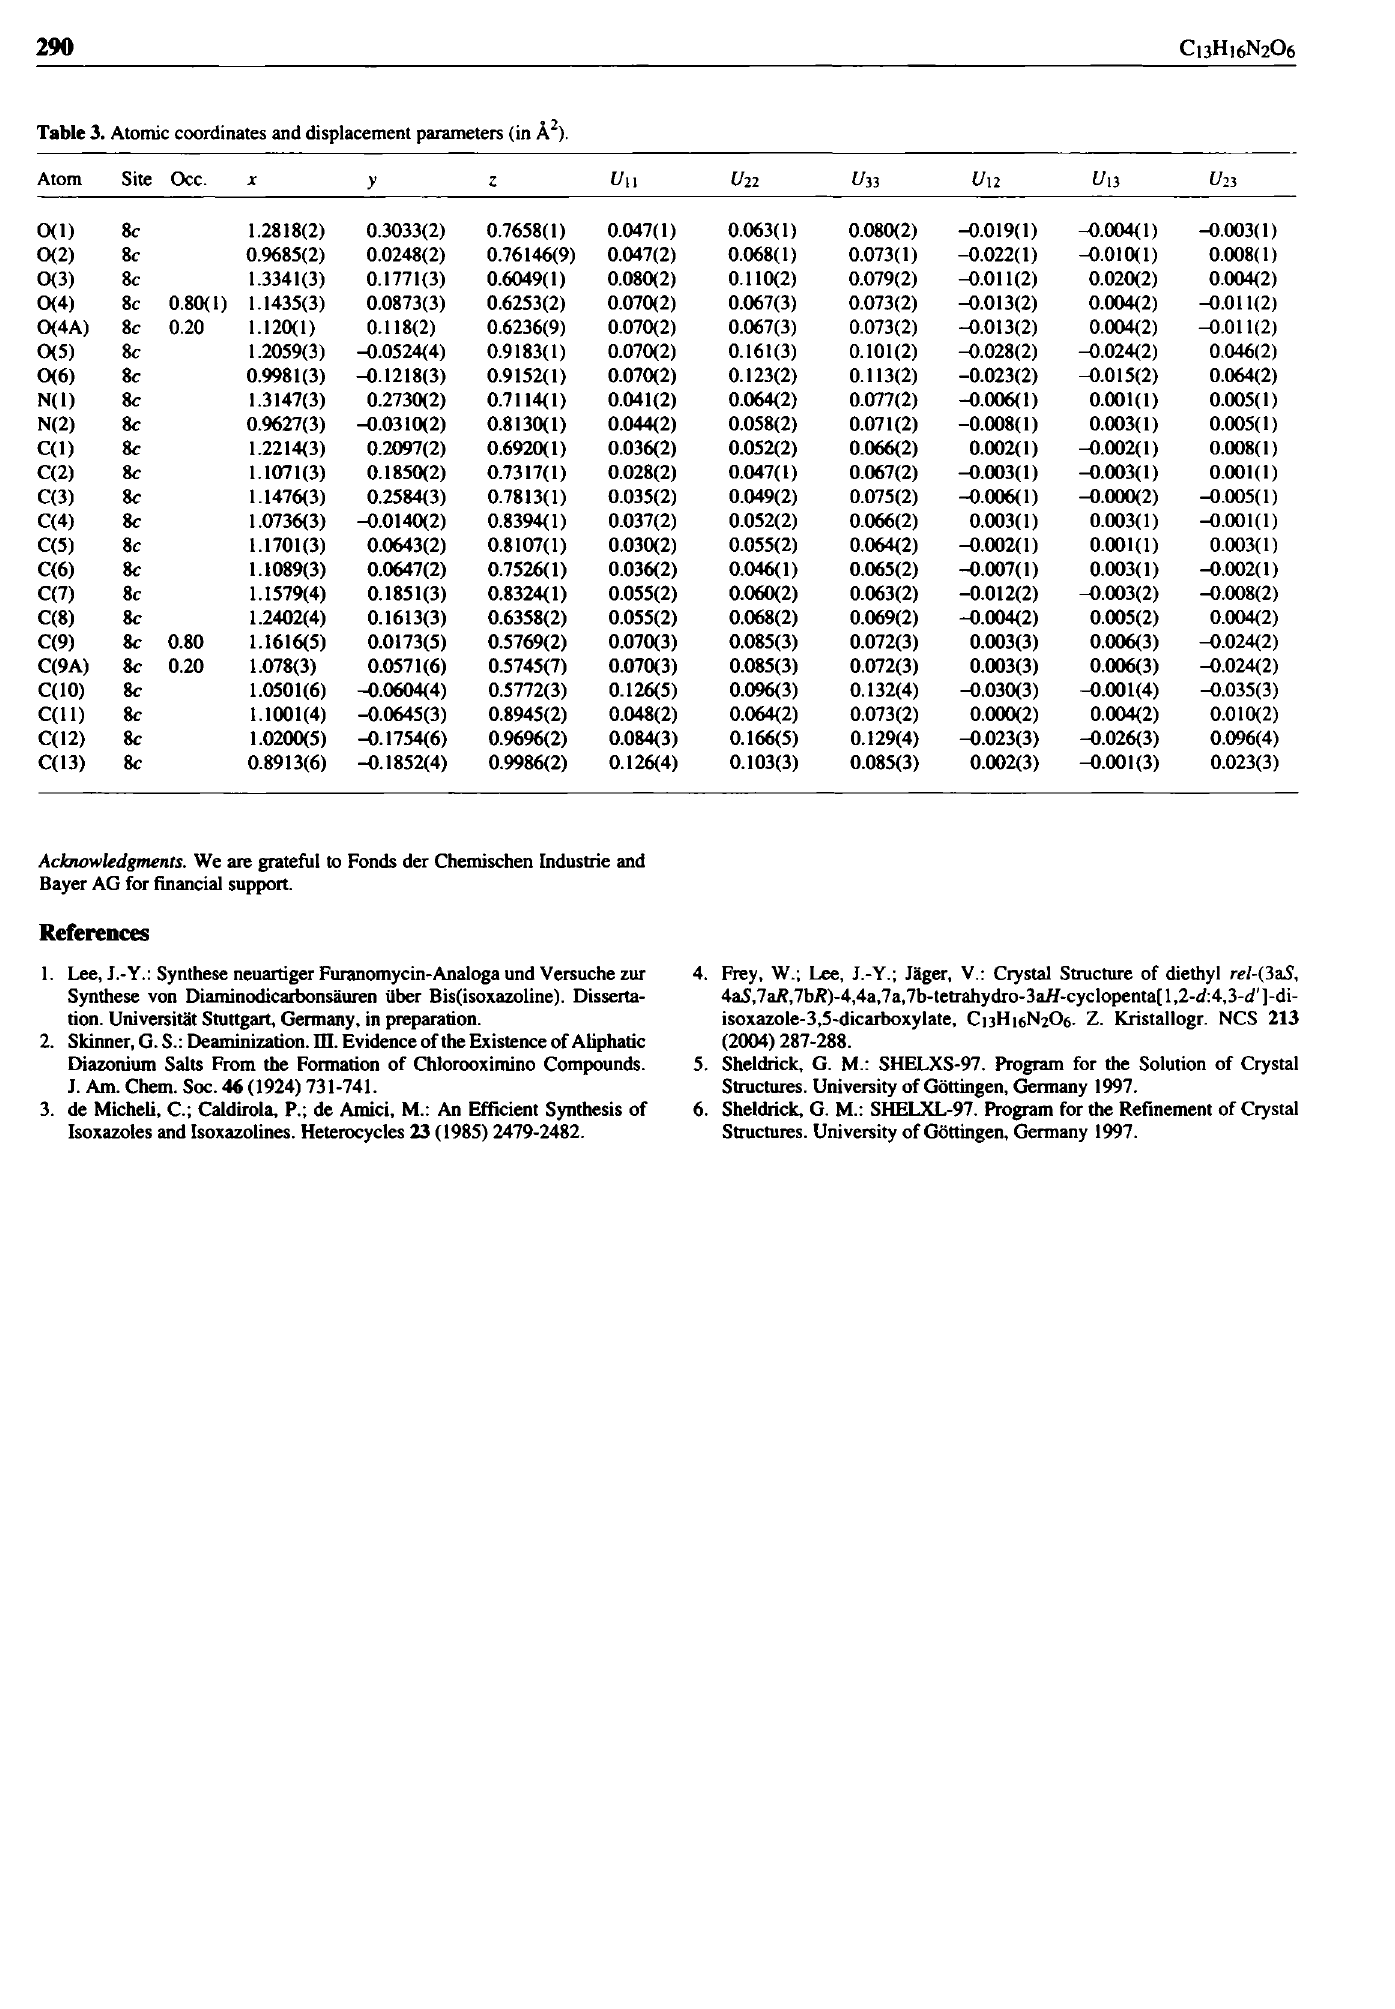
Table 3. Atomic coordinates and displacement parameters (in Â 2